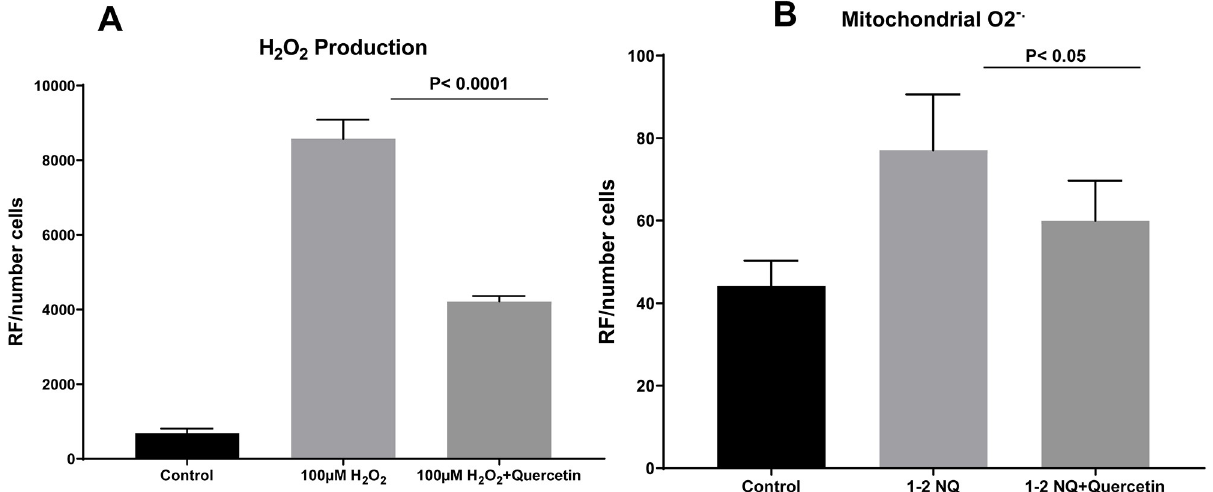
Fig 5. Quercetin reduces cellular and mitochondrial oxidative stress in human airway epithelial cells. Human bronchial epithelial cells in ALI state, control, and treated with 25 μ M quercetin. A) H 2 O 2 production p < 0.0001, N = 4. B) Mitochondrial ROS production p < 0.05, N = 5 one-way ANOVA.